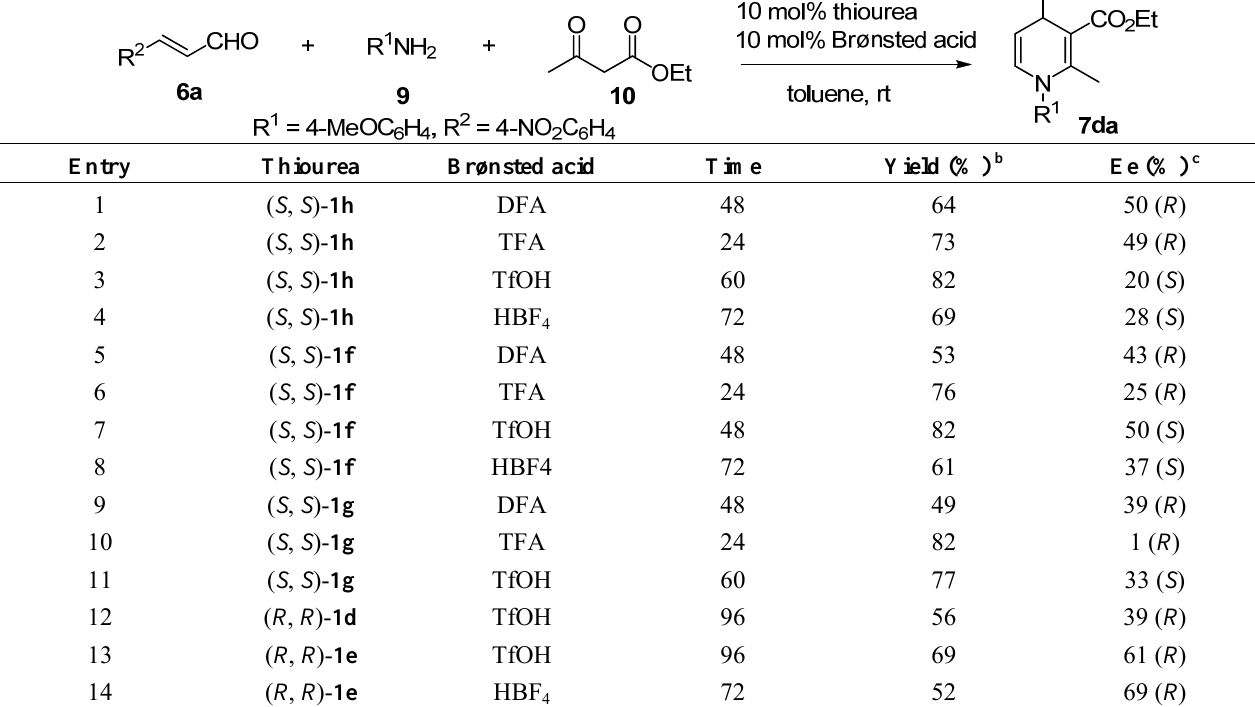
Table 5. Three-component cyclization catalyzed by Brønsted acid-anilinothiourea co-catalysts.